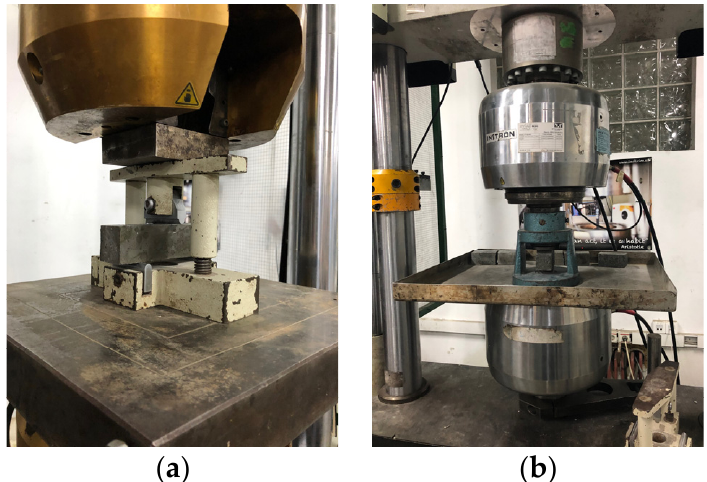
Figure 3. Set up of the flexural ( a ) and compression strength test ( b ).